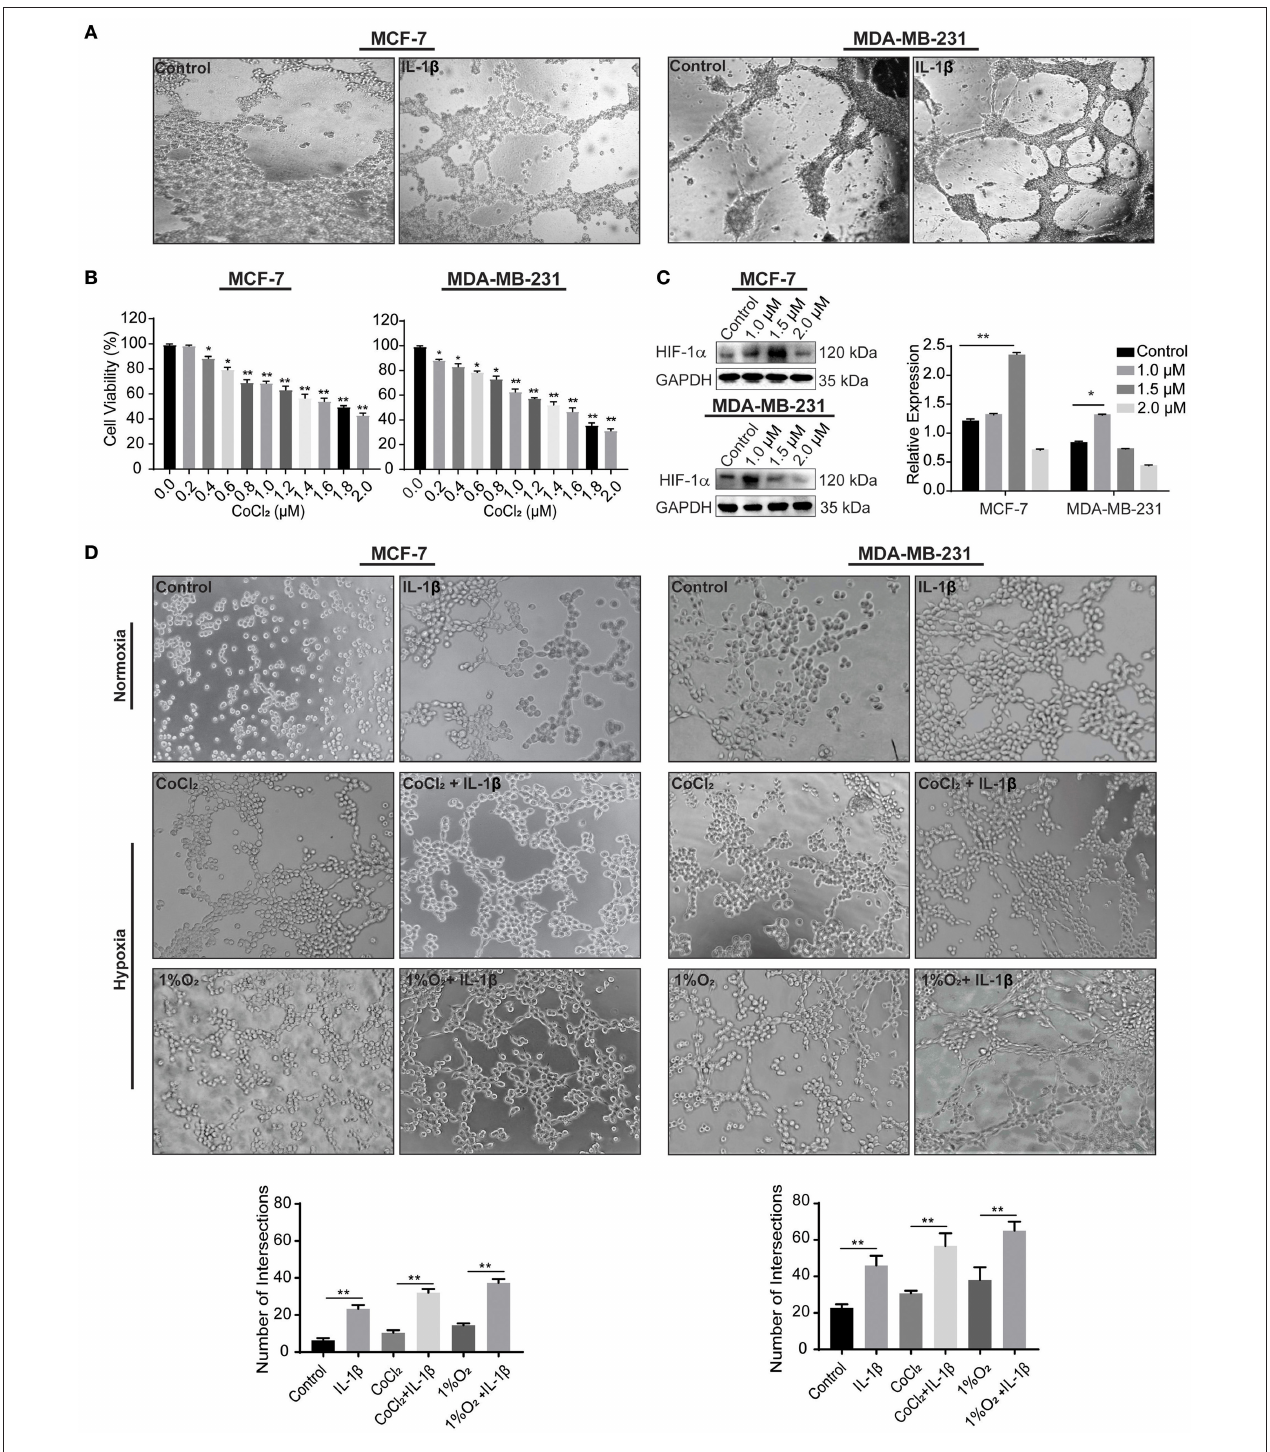
FIGURE 3 | IL-1 β promotes the microvessel like intersections in normoxia and hypoxia. (A) Matrigel based tube formations assay for the evaluations of intersections formed in response to IL-1 β (15ng/ml) in MCF-7 and MDA-MB-231 breast cancer cells at 48h. (B) Cytotoxicity of CoCl 2 was evaluated by CCK-8 assay in cells treated with different concentrations of CoCl 2 (0, 0.2, 0.4, 0.6, 0.8, 1.0, 1.2, 1.4, 1.6, 1.8, and 2.0 µ M), and One-way ANOVA was performed following Sidak’s multiple comparisons with * p < 0.05, ** p < 0.01 vs. control group. (C) Western blot analysis of HIF-1 α expression in CoCl 2 treated breast cancer cells. (D) Cord formation assay was performed to evaluate intersections in cells treated with IL-1 β (15ng/ml) in normoxic and hypoxic conditions (CoCl 2 and 1% O 2 ). Statistical analysis was performed through multiple t -test comparisons with * p < 0.05, ** p < 0.01 compared to the control.